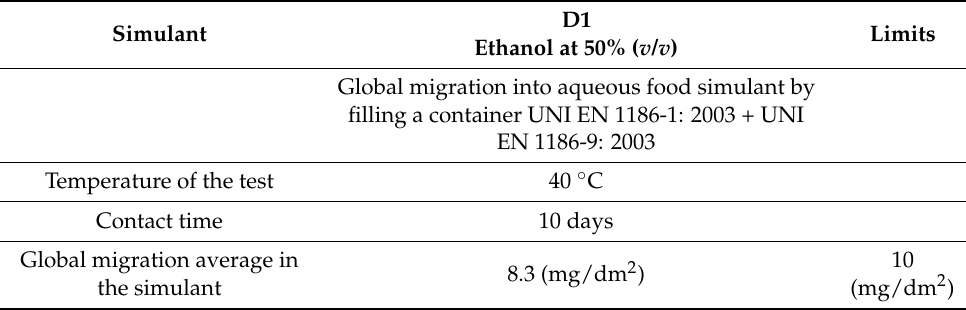
Table 2. Global migration from the active PE-Active Filler.